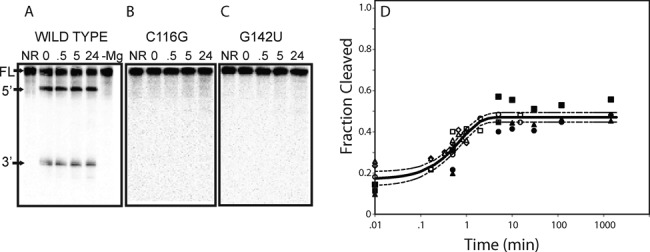
(Left) Cleavage assay reactions (A,B,C) of designed hammerhead (wild-type), mutant C116G and mutant G142U. For the wild-type (A), mutant C116G (B), and mutant G142U (C) gel images, lane 1 is the undigested RNA (full-length, FT), lanes 2–5 are reactions in cleavage buffer (50 mM Tris pH 7.5, 5 mM MgCl2) at the 0 s, 30 min, 5 h and 24 h time points respectively (5′ and 3′ cleavage products indicated). For the wild-type (A), lane 6 is a reaction lacking Mg (50 mM tris pH 7.5) incubated for 24 h. It is evident that cleavage only occurs for the wild-type sequence, and when Mg is present. (Right) Cleavage time series curve (D) for the 166 nt designed hammerhead, with observed cleavage rate of 1.3/min with an Fmax of 0.47 and MSE of 0.0026. This construct displays kinetics comparable with that of wild-type hammerheads, although the cleavage amount Fmax is much lower than that of wild-type hammerheads.